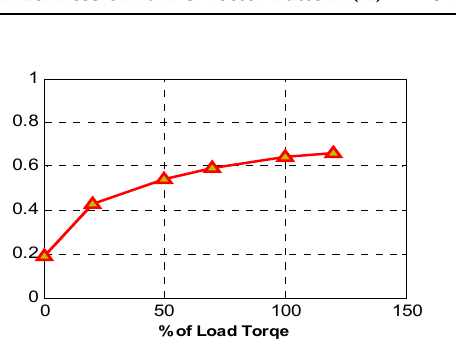
Figure 12. Influence of the load torque on the thickness of the Park’s vector pattern of a motor with a BRB.